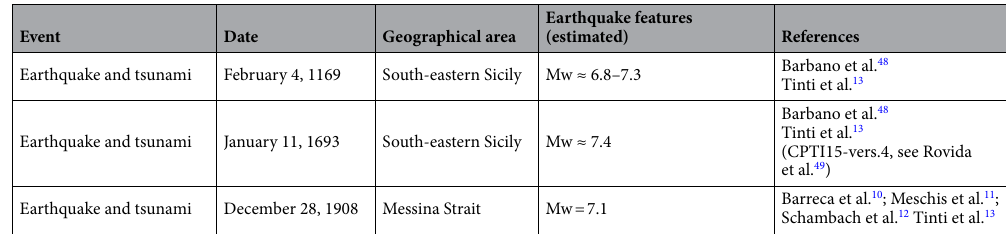
Table 1. Earthquake-related tsunami impacting the coasts of south-eastern Sicily in historical times, with relative moment magnitude